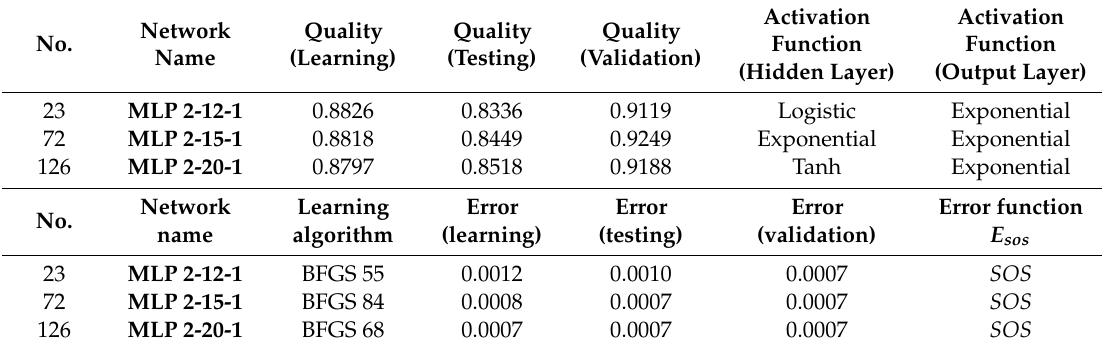
Table 2. Selected neural networks based on vibration acceleration analysis (generated in Statistica).